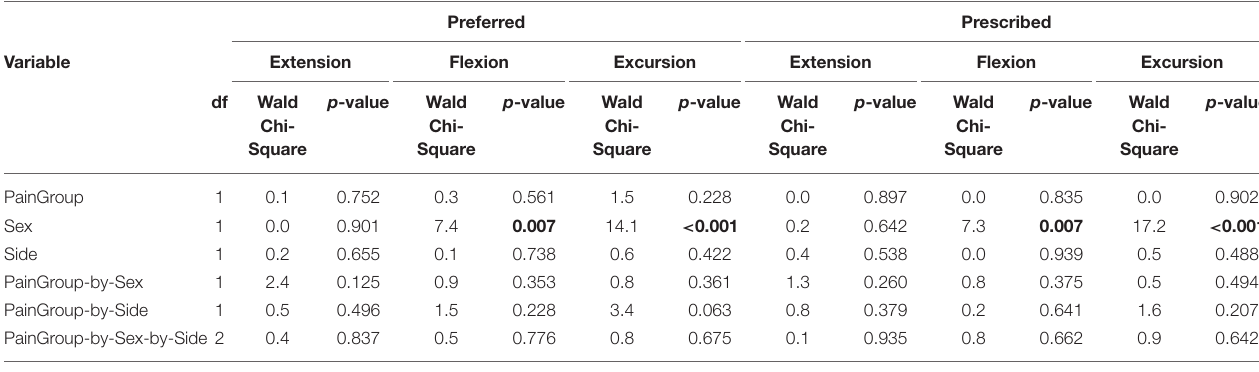
TABLE 5 | Results of linear regression with generalized estimating equation correction for each dependent variable (hip extension, flexion, and excursion) limited to individuals with PAHD modeling PainGroup (pain with walking, no pain with walking) at the self-selected preferred walking speed and the prescribed (1.25 m/s) walking speed.